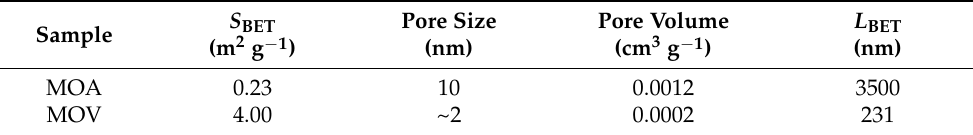
Table 4. BET specific surface area ( S BET ) and average pore size and pore volume of the MOA and MOV